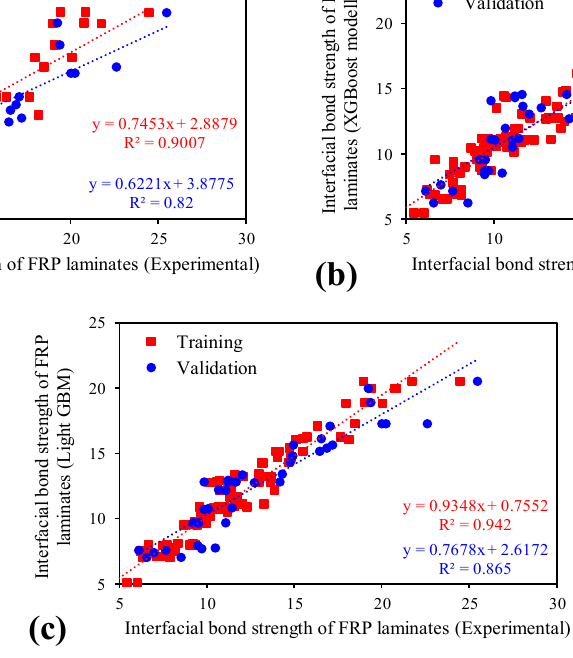
Figure 3. Comparison of the regression slopes’ trends between experimental and predicted values for the developed models: ( a ) RF, ( b ) XGBoost, and ( c ) LIGHT GBM. (ii) Error analysis